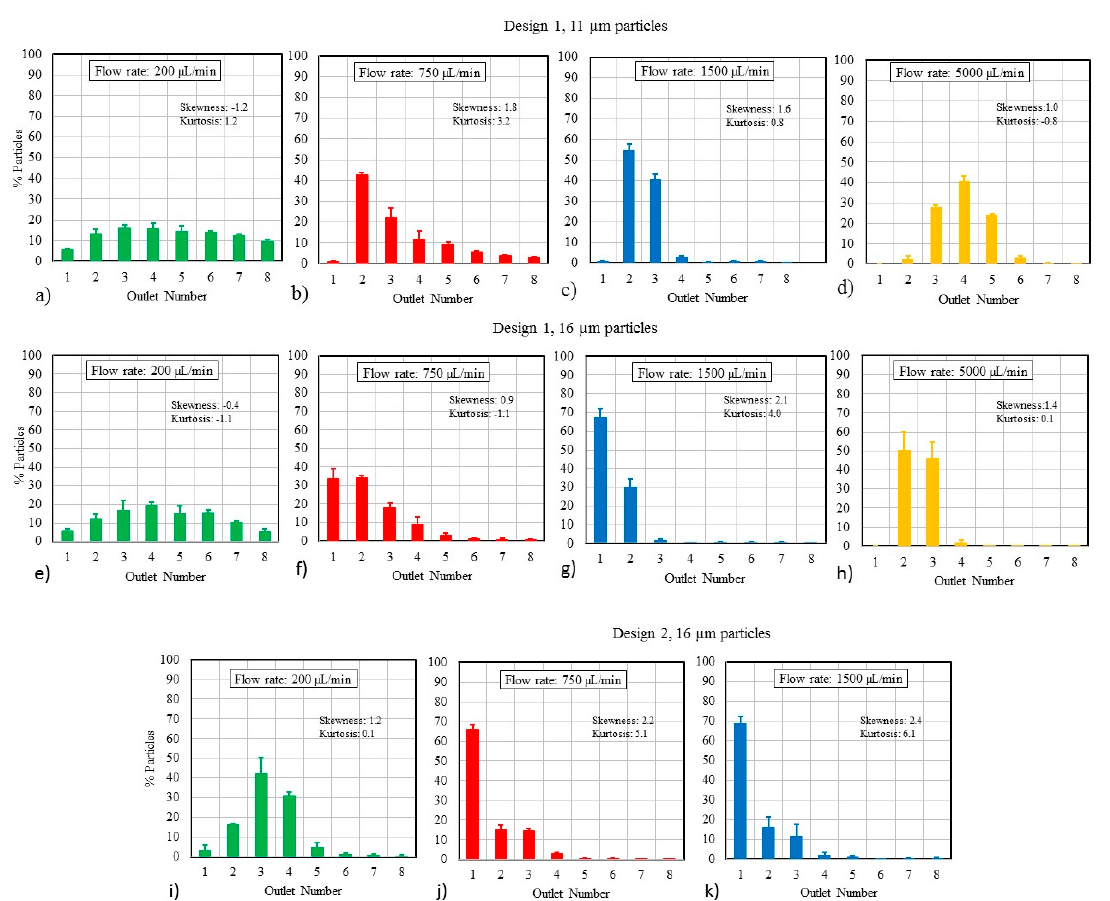
Figure 3. ( a – d ) Particle distributions for Design 1 using 11-µm particles at different flow rates, showing focused particle streams shifted away from the inner wall with an increase in flow rate. ( e–h ) Particle distributions using Design 1 for 16-µm particles at different flow rates. The 16-µm particles focus closer to the inner wall compared to the 11-µm particles. ( i–k ) Particle distributions for 16-µm particles at different flow rates using Design 2.